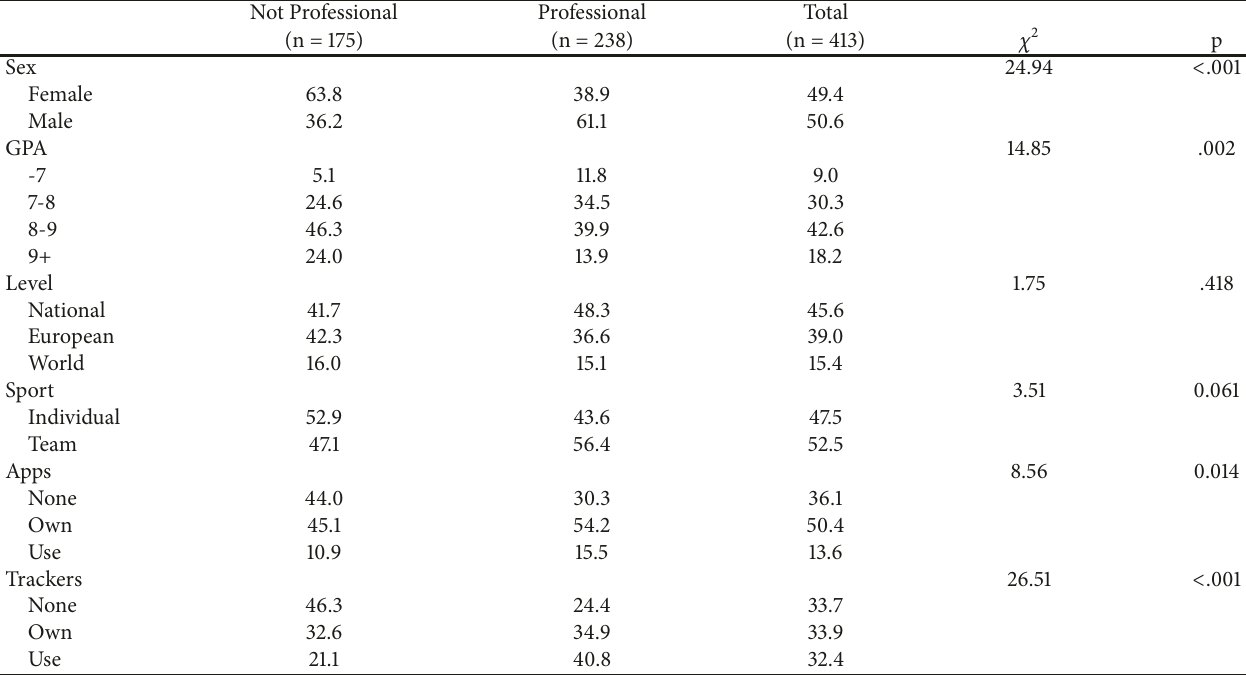
Table 2: Proportions (in %) of professional aspiring athletes by demographics.